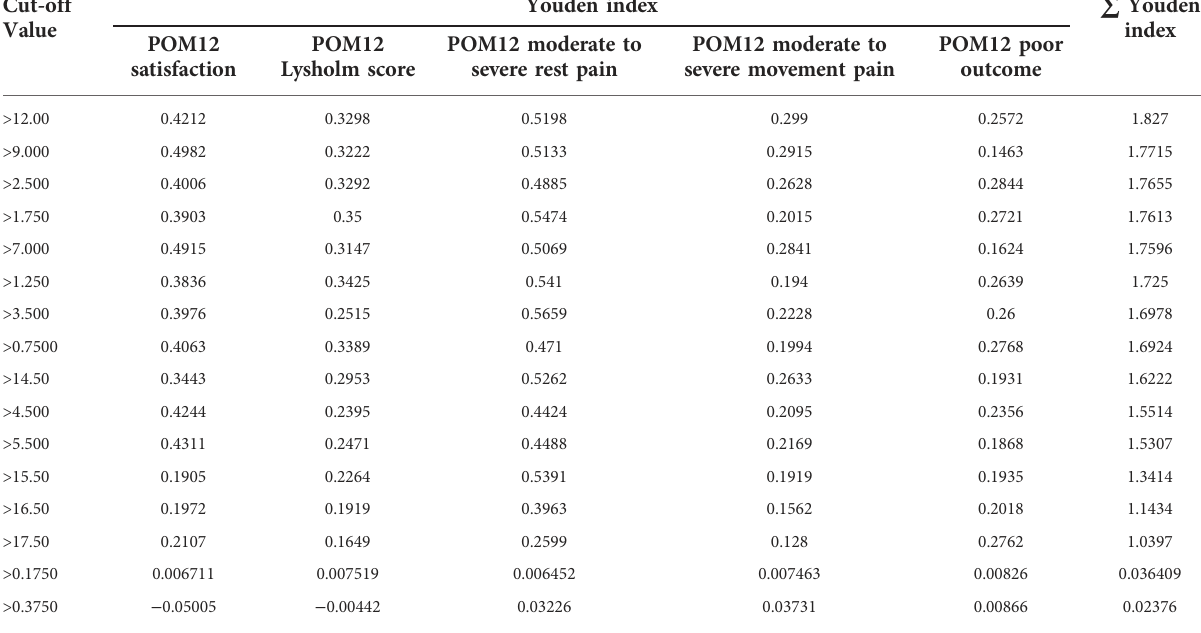
TABLE 3 Youden index of ROC curves of DAU (sorted by ∑ Youden index in descending order). Cut-off